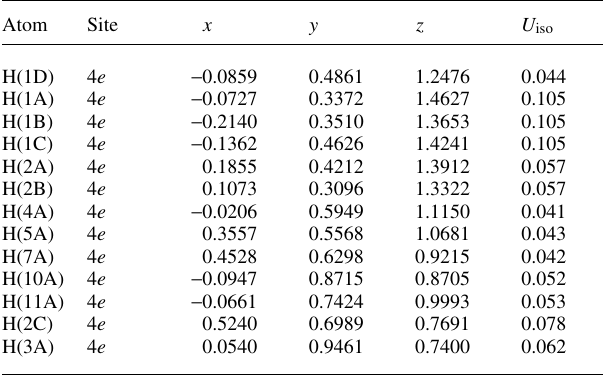
Table 2. Atomic coordinates and displacement parameters (in Å 2 )